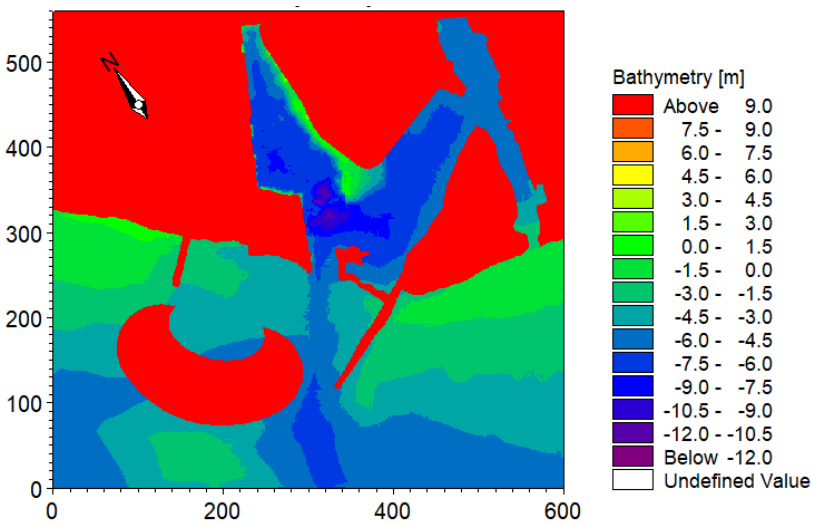
Figure 9. Mesh and bathymetry.